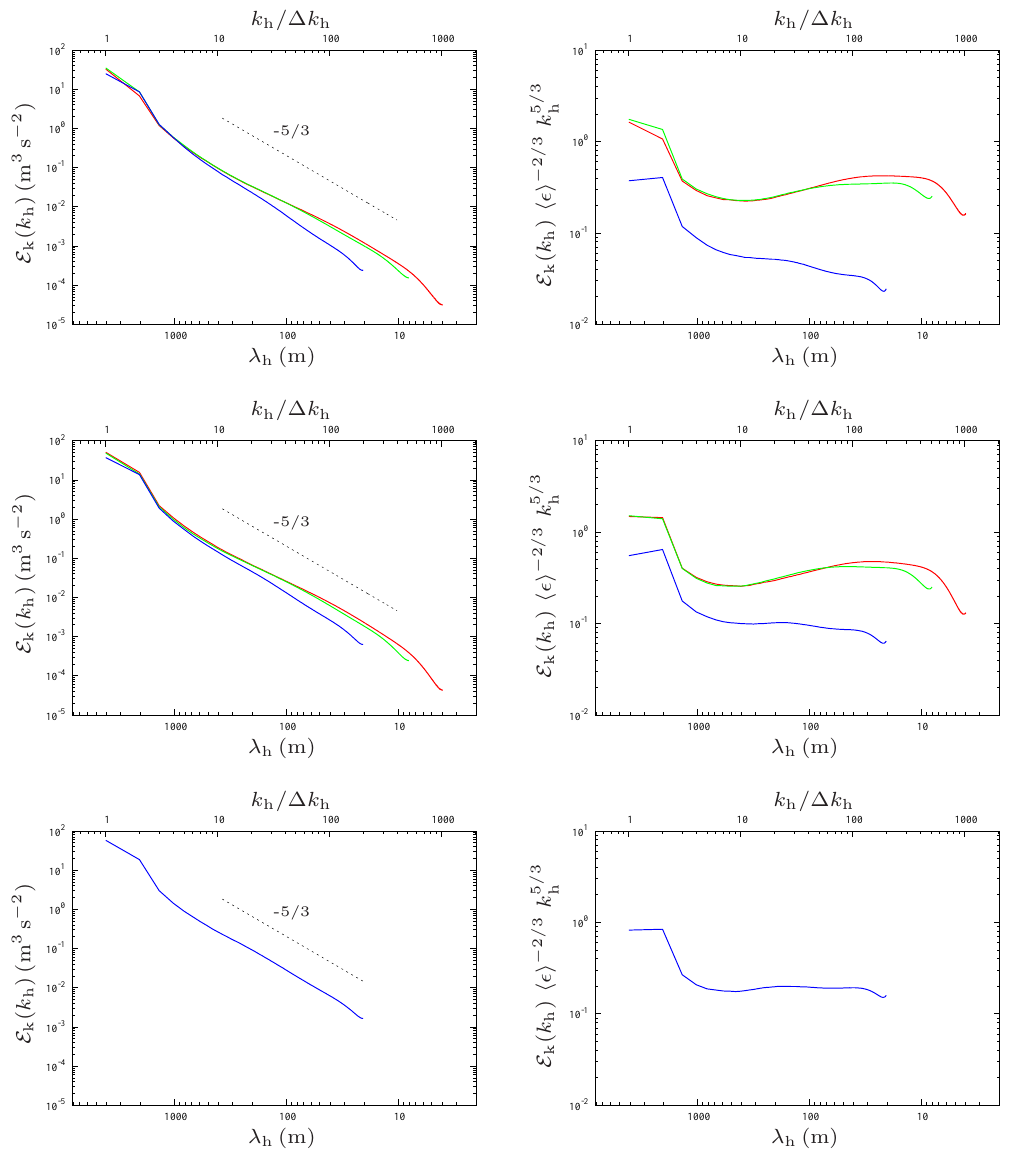
Figure 11. Horizontal turbulent kinetic energy spectra (left panels) and compensated spectra (right panels). From top to bottom: strong forcing, moderate forcing, and weak forcing case. Red lines: 1 = 2m; green lines: 1 = 4m; blue lines: 1 =